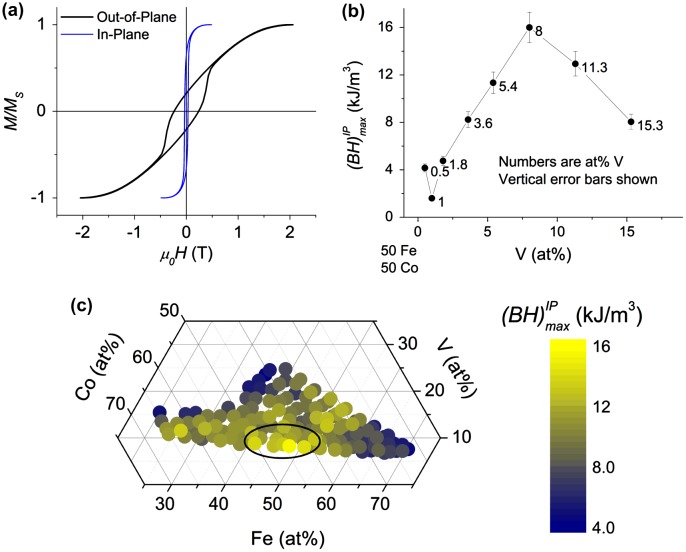
(a) VSM results for in-plane and out-of-plane M(H) loops of an Fe38Co53V9 sample. Data were normalized to facilitate comparison of saturation for in-plane and out-of-plane loops. (b) In-plane (BH)max values were calculated from VSM hysteresis loops from library UMD1 and plotted versus the V content of alloys with equal atomic concentrations of Fe and Co. Each point is labeled with at% V and the error in (BH)max is shown as vertical bars. (c) (BH)max map values were calculated from in-plane VSM loops of library RUB. The (BH)max values were color mapped and plotted on the ternary composition diagram for the Fe-Co-V system. The nominal Vicalloy region is circled in black as studied by Nesbitt [10].